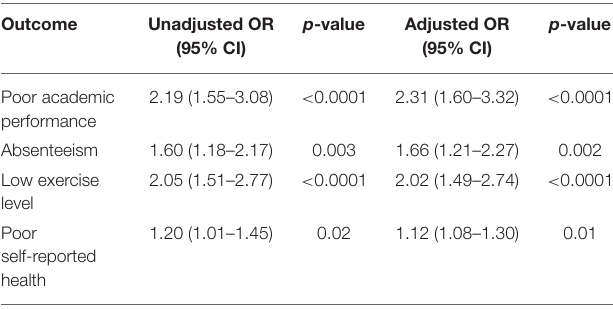
TABLE 6 | Unadjusted and adjusted odds ratios of the association of effort-reward imbalance with poor academic performance, absenteeism, and self-reported health.